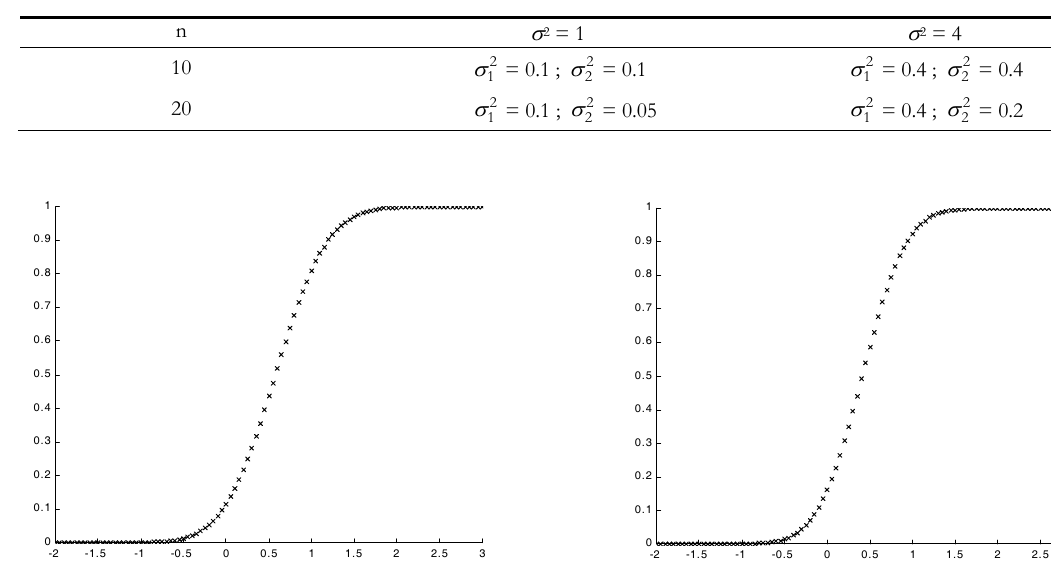
Figure 1 – Prevision of satisfaction for l = 1. Figure 2 – Prevision of satisfaction for l = 1.